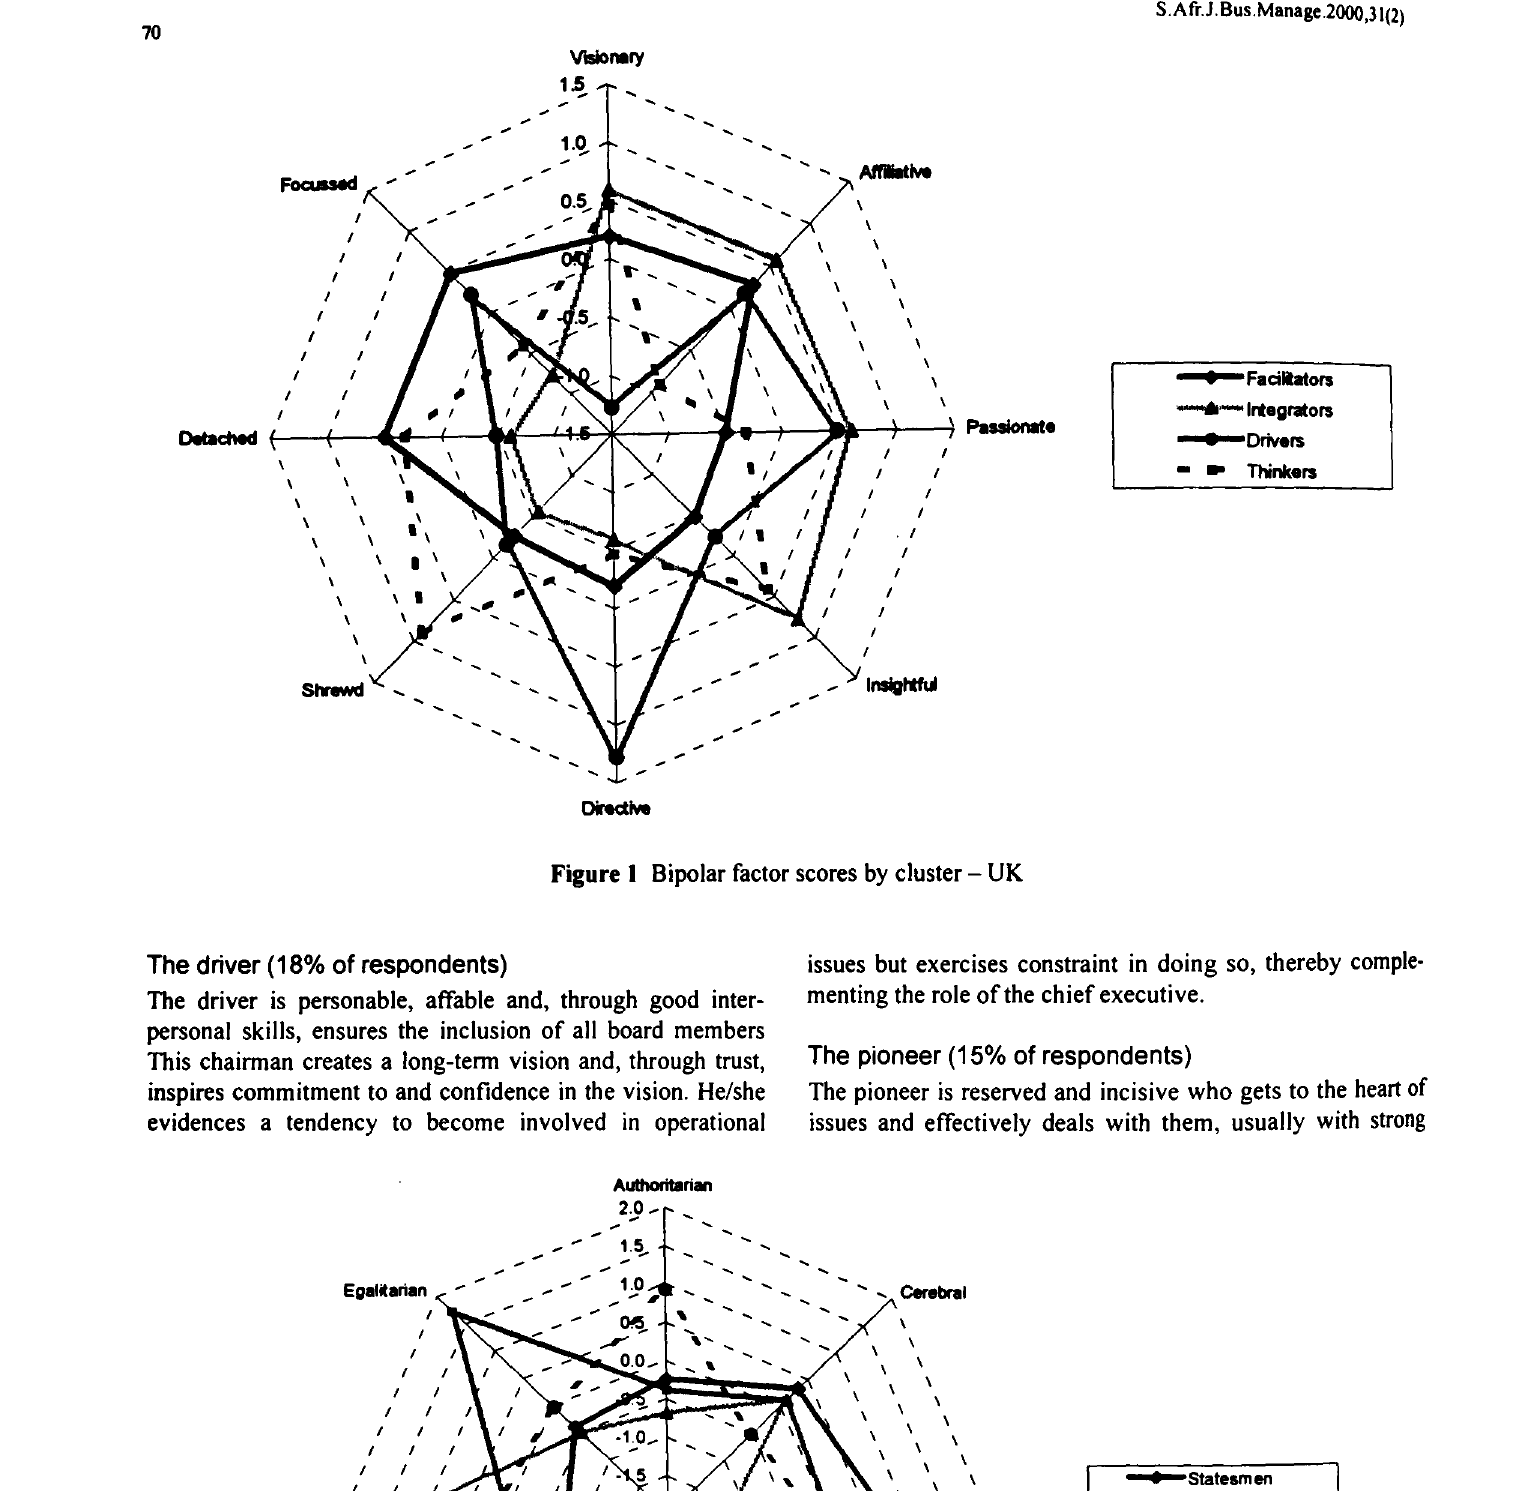
Figure 2 Biploar fact r scores by cluster - South